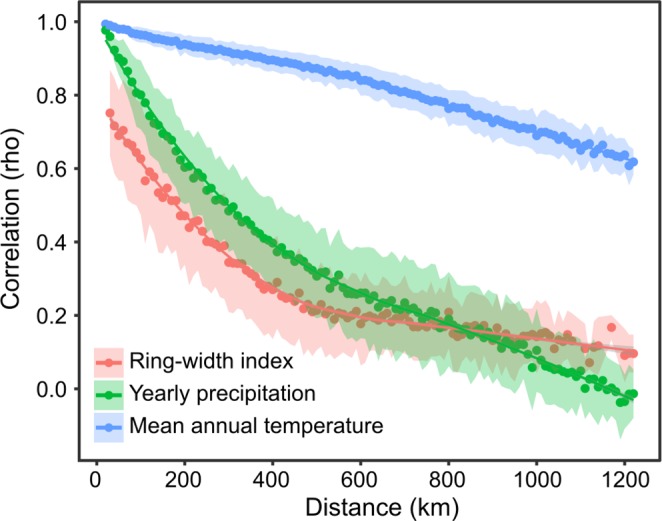
Average effect of geographical distance on the similarity between tree-ring width index, yearly precipitation and mean annual temperature times series built at the landscape scale.Spearman correlations, averaged per binned distance (30-km intervals), were used to compare chronologies. The blue area represents the standard deviation from the means. The exponentially decreasing pattern is identical across all spatial scales.